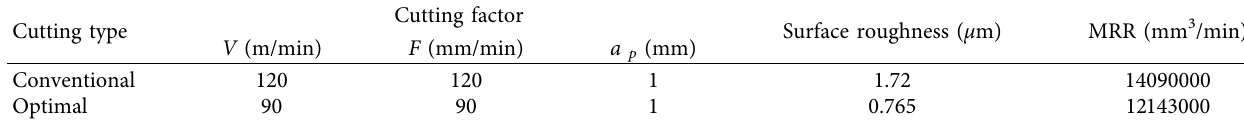
Table 7: Comparison of experimental results.